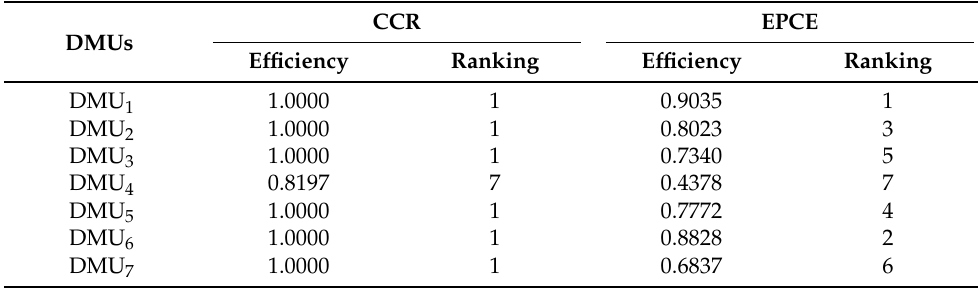
Table 4. Results of the CCR model and the EPCE